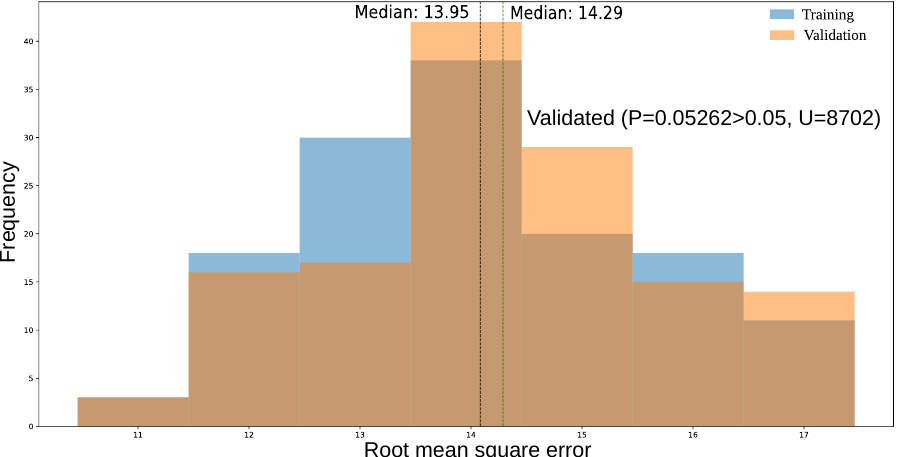
Figure 4. The histograms of root mean sum of squared differences between model solution and data in terms of the number of days from sowing to flowering for training and validation sets. Vertical lines correspond to the